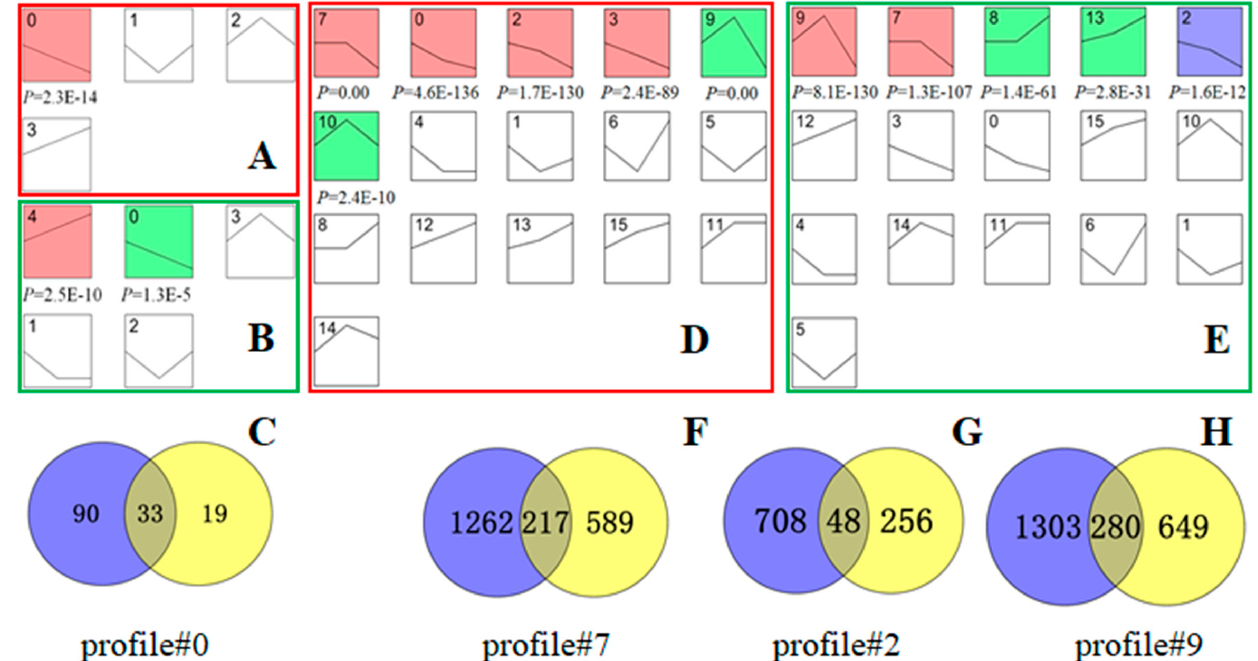
Figure 5. Screening of DEGs with the same trend in spermatids and sperm of bovine and mouse. The bovine ( A , D ) and mouse ( B , E ) trend charts of DEGs. Diagrams ( A , B ) are trend diagrams of 344 homologous genes searched in mouse sequencing data for 517 DEGs at the stage of bovine round to elongated spermatid. Diagrams ( D , E ) are trend diagrams of 6259 homologous genes searched in mouse sequencing data for 7279 DEGs from bovine elongated spermatid to epididymal sperm. The coloured profile graph indicates statistical significance ( p < 0.05). After comparing ( A , B ), the profile#0 gene set with the same expression trend and statistical significance was screened out. ( C ) Venn diagram of the cattle and mouse profile #0 gene sets. After comparing the ( D , E ) graphs, the profile#7, profile#2, and profile#9 gene sets with the same expression trend and statistical significance were screened. ( F – H ) Venn diagrams of the profile#7, profile#2, and profile#9 gene sets of spermatids and sperm of bovine and mouse, respectively. In ( C , F – H ), the blue gene set represents the bovine homotopic gene and the yellow represents the mouse homotopic gene.